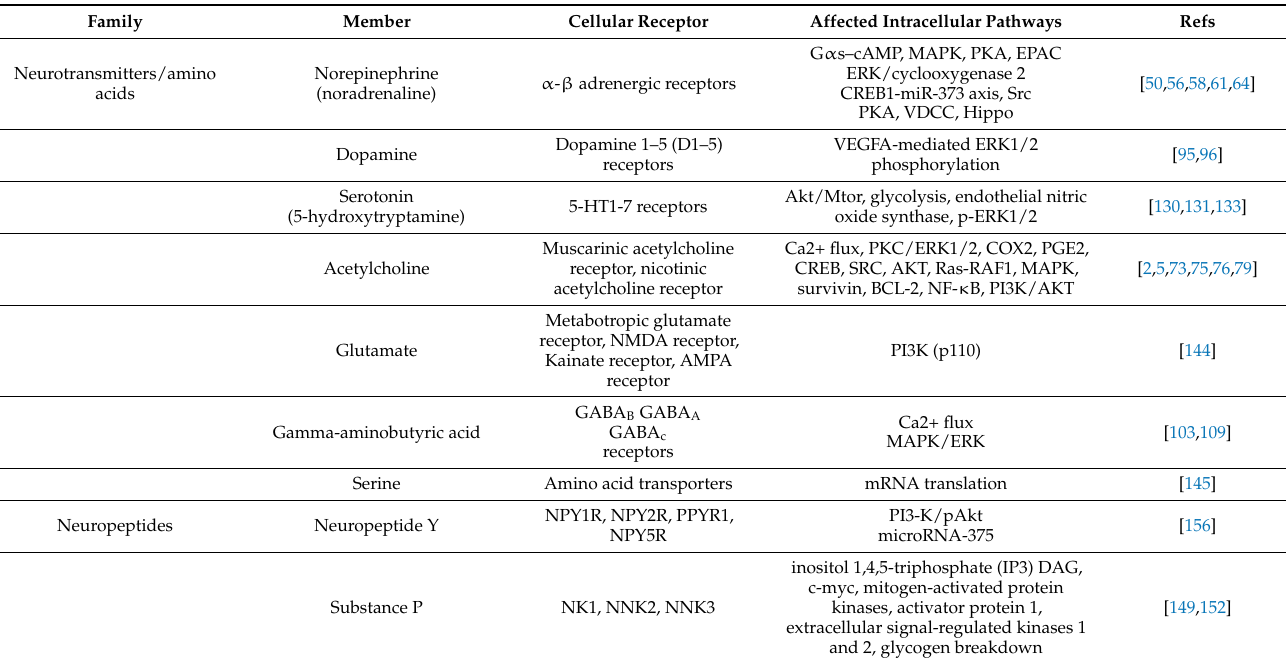
Figure 3. Outline of the tumor cell/ nervous system interfaces and their biological effects on can- cer cells that have been cited in this review. Up arrows indicate the upregulation of a certain pathway/phenotype. Down arrows indicate downregulation. CD: context-dependent, means that variable responses depend on the tumor type and various other experimental conditions. Intra- and intertumor heterogeneity most likely play a role. All other abbreviations can be found in the main text. Table 1. A schematic presentation of the neurotransmitters/amino acids/growth factors considered in this review, with molecular data. More details on the intracellular pathways, including the abbreviations used, can be found in the main text and